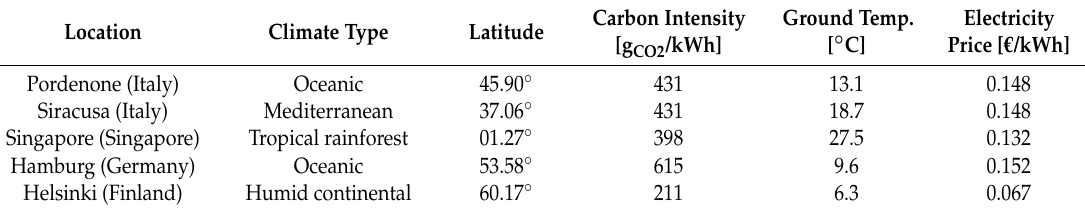
Table 6. Main features for different